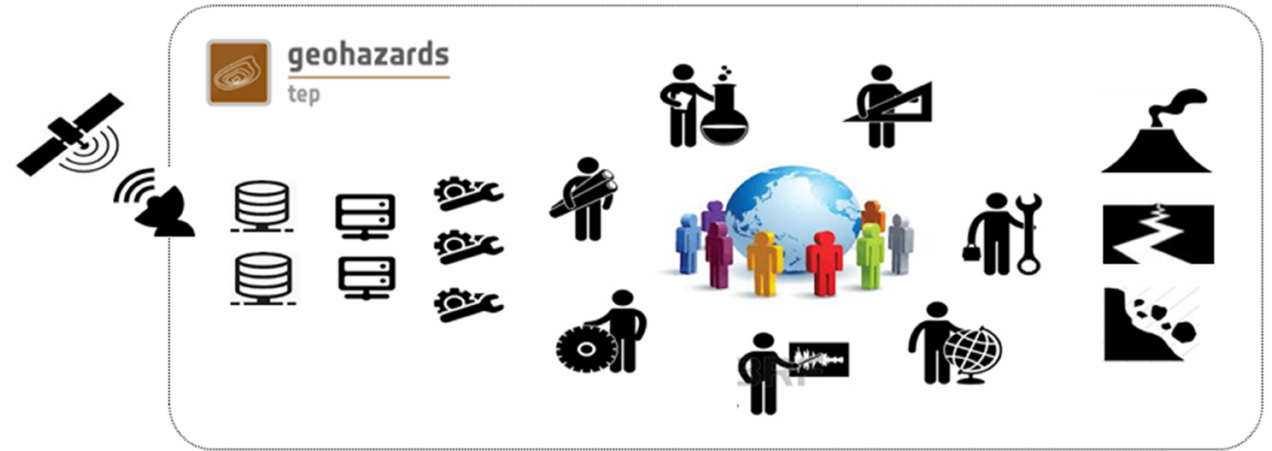
Figure 1. The concept of the Geohazards Exploitation Platform in bringing EO data and processing services closer to EO practitioners utilizing state-of-the-art cloud-based solutions in responding to geohazard